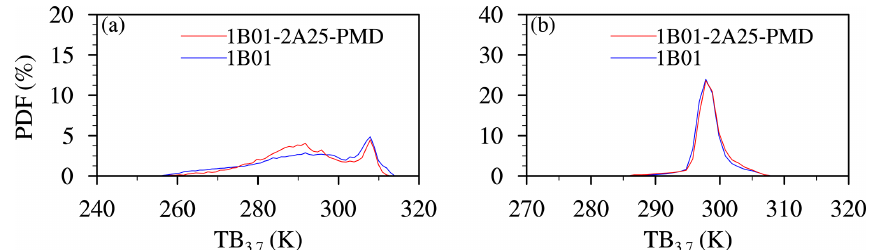
Figure 2. PDFs of TB 3 . 7 in (a) cloudy regions and (b) clear-sky regions in 1B01 (blue line) and 1B01-2A25-PMD (red line) for orbit number 37362 on 5 June 2004.